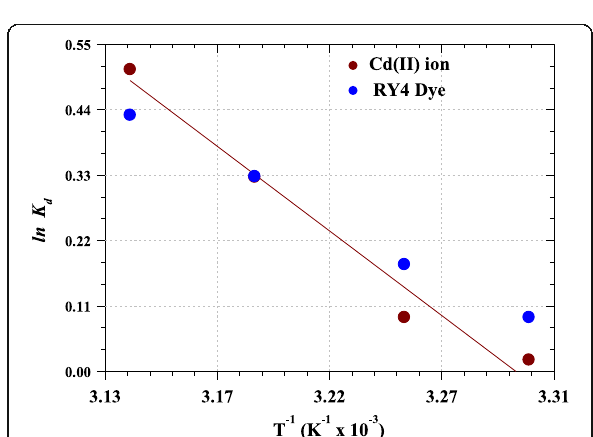
Fig. 14 Thermodynamics fit for adsorption of Cd(II) ion and RY4 dye by